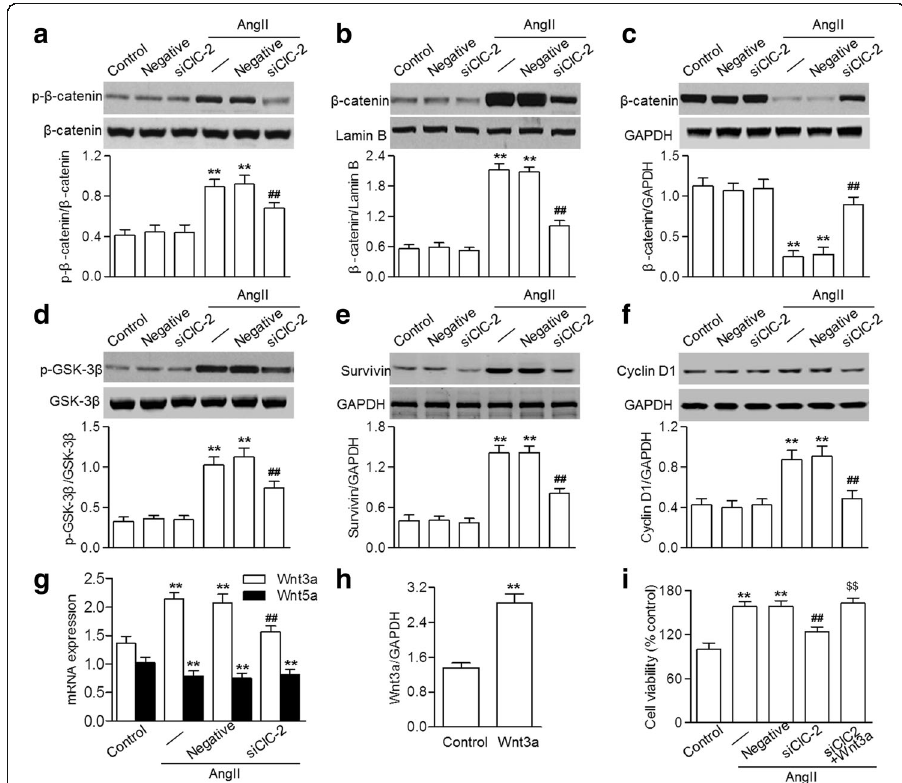
Fig. 4 ClC-2 inhibition attenuated the AngII-induced activation of Wnt/ β -catenin signaling. a through f HBVSMCs were transfected with ClC-2 siRNA (siClC-2; 20 nM) or negative siRNA (negative; 20 nM) and then stimulated with angiotensin II (AngII; 10 − 7 M) for 48 h. Shown are the western blotting results for β -catenin phosphorylation ( a ), β -catenin cytosol ( b ) and nuclear protein ( c ) levels, GSK-3 β phosphorylation ( d ), and survivin ( e ) and cyclin D1 ( f ) protein expression. g Quantitative real-time PCR analysis of Wnt3a and Wnt5a mRNA expression. h The cells were treated with recombinant Wnt3a (100 ng/ml) for 48 h. Wnt3a expression was examined using quantitative real-time. i Viability of HBVSMCs transfected with ClC-2 siRNA followed by co-incubation with recombinant Wnt3a and AngII. ** p < 0.01 vs. control, ## p < 0.01 vs. AngII alone, $$ p < 0.01 vs. AngII+siClC-2, n =